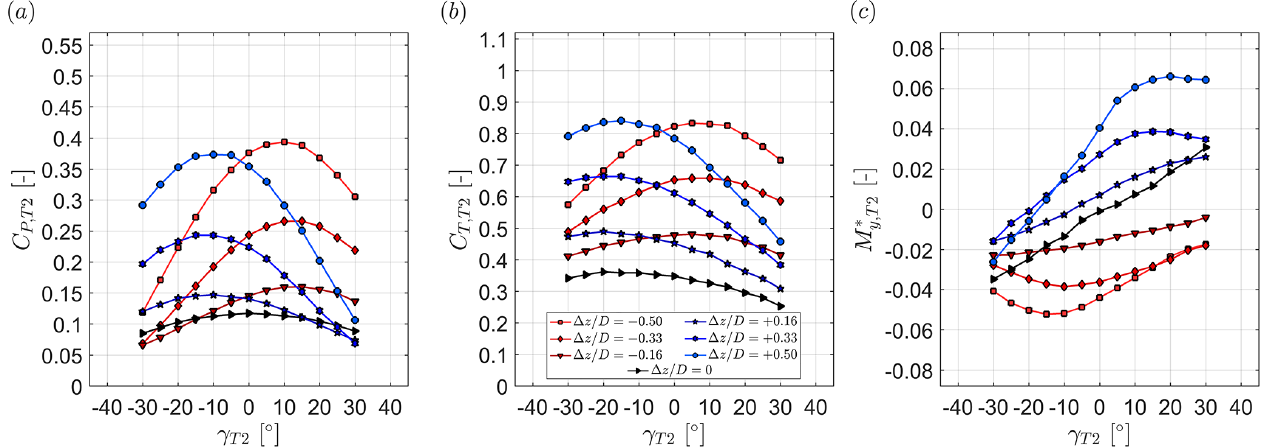
Figure 11. Downstream turbine (a) power coefficient, (b) thrust coefficient and (c) normalized yaw moment as a function of its yaw angle γ T2 for different lateral offset positions (cid:49)z/D . The upstream turbine yaw angle is kept constant at γ T1 = 0 ◦ . The downstream turbine T2 is located at x/D = 3. The turbines are exposed to inflow